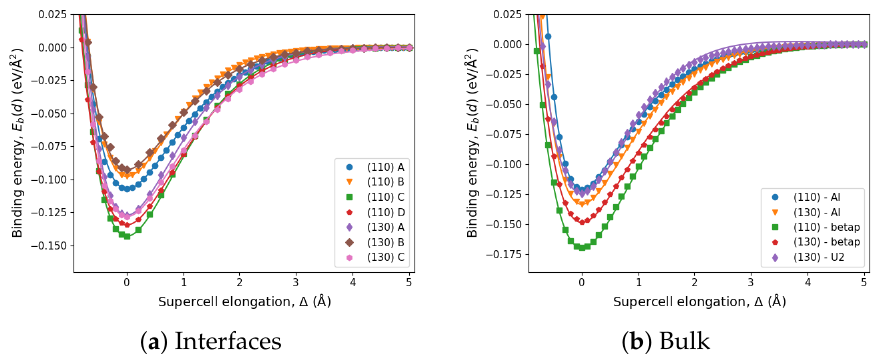
Figure 7. (Color online) Fitted binding energies as a function of supercell elongation. The solid lines are fitted using Equation (9). It turned out to be sufficient to only include one term in P ( a ) = P 3 a 3 and non in Q ( a ) = 0 to get an excellent fit.